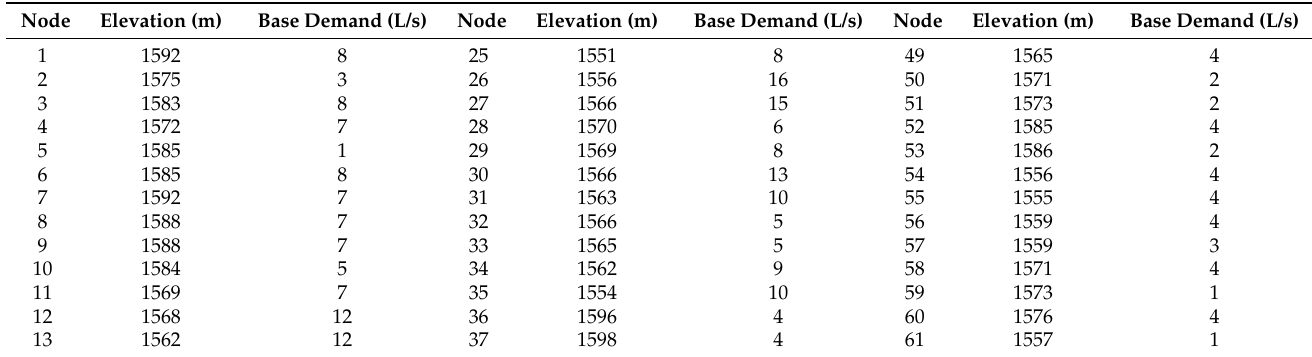
Table 1. Information on Baharestan’s